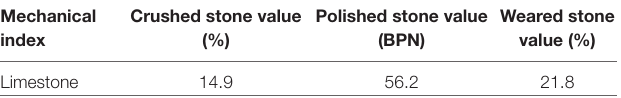
TABLE 3 | Mechanical index of coarse aggregate.